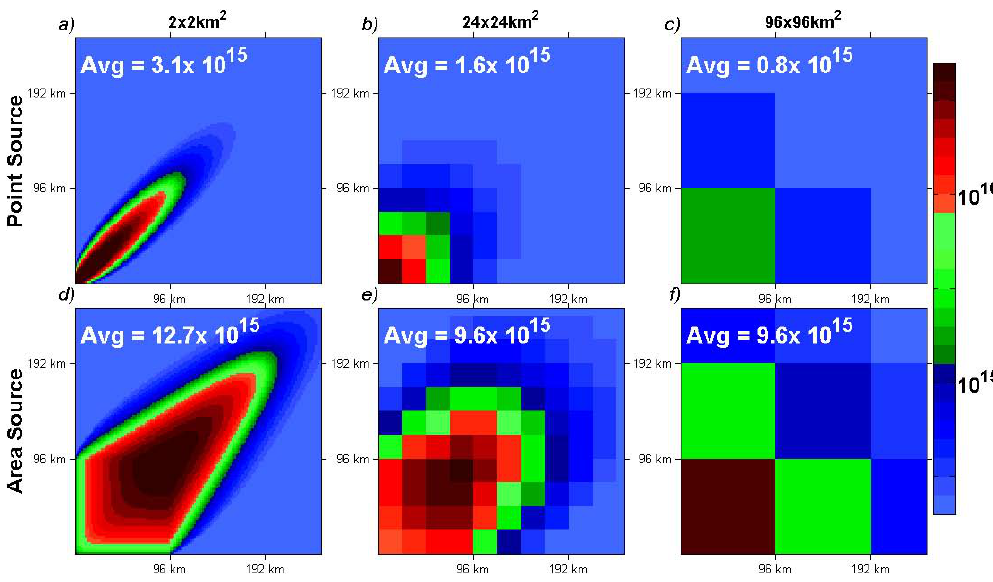
Fig. 4. NO 2 column (moleculescm − 2 ) predicted in a 2-D plume model for a large point source simulated at (a) 2km, (b) 24km, and (c) 96km resolution, and the same for simulation of a large area source (d–f) . The color-scheme corresponds to NO 2 -OH feedback regimes depicted in Fig. 1. The vertical layer is fixed at 1km thickness for all simulations